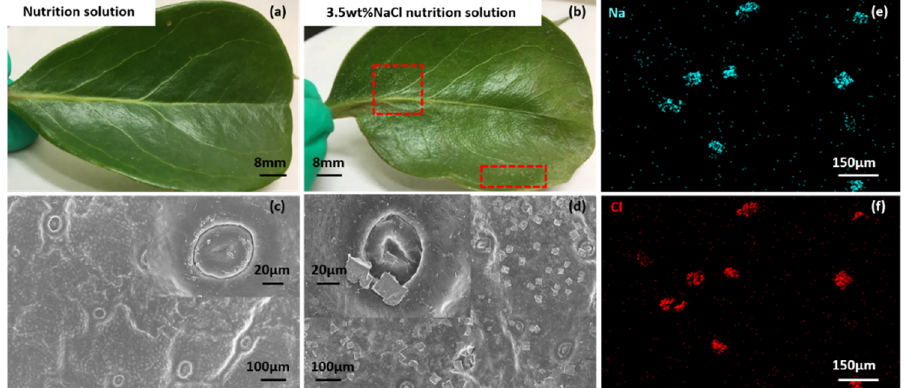
Figure 2. The deposited salt on the surface of cultured mangrove leaves. ( a ) and ( b ) are mangrove leaves cultured by nutrition solution and 3.5 wt. % NaCl nutrition solution, respectively. ( c ) and ( d ) are SEM images of mangrove leaves deposited with salt particles and the inserted images are the salt glands of mangrove leaves. ( e ) and ( f ) are EDS of the deposited salt particles.